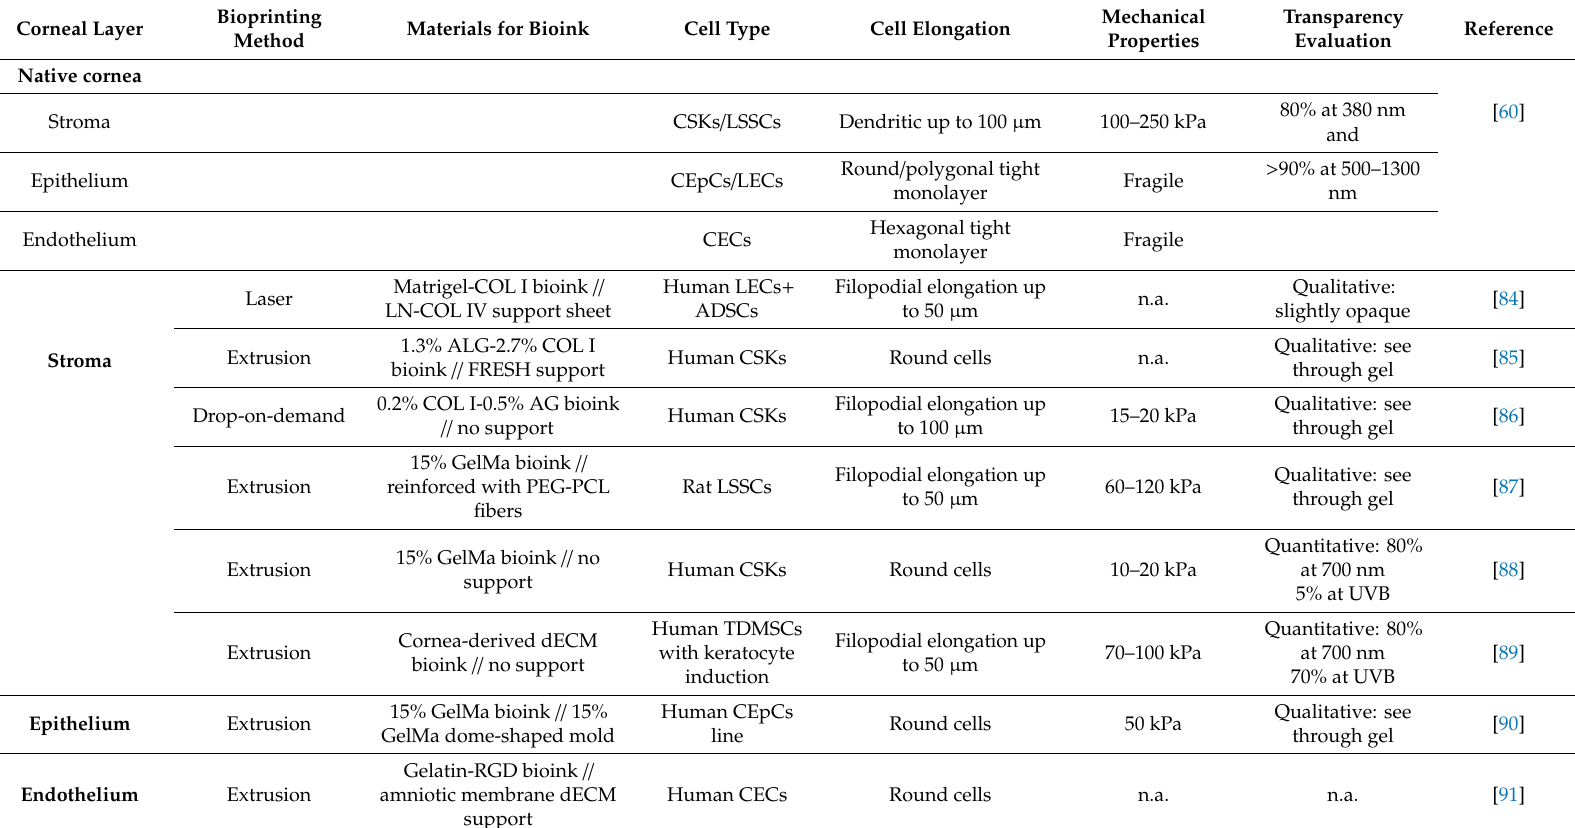
Table 1. Summary of original studies performed in 2018–2020 on corneal